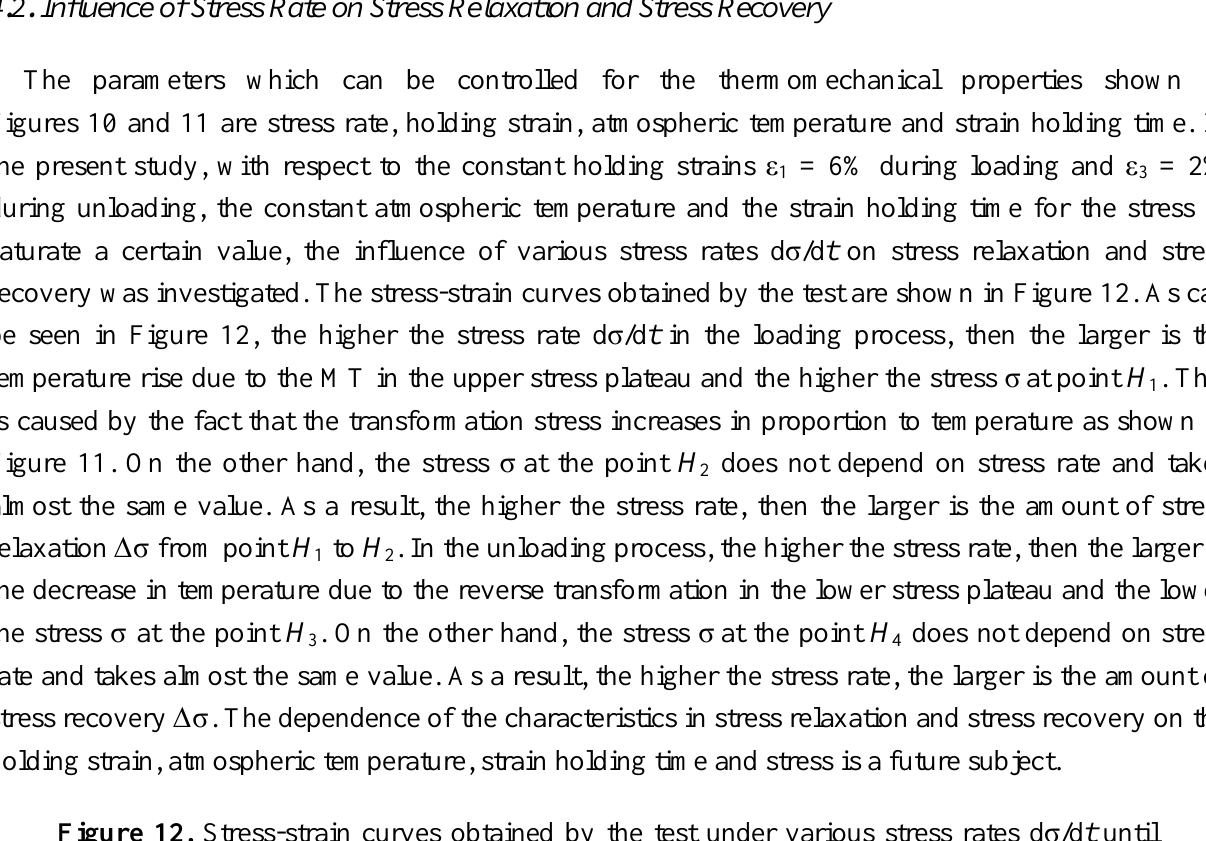
= 6% and thereafter unloading until 1 = 3